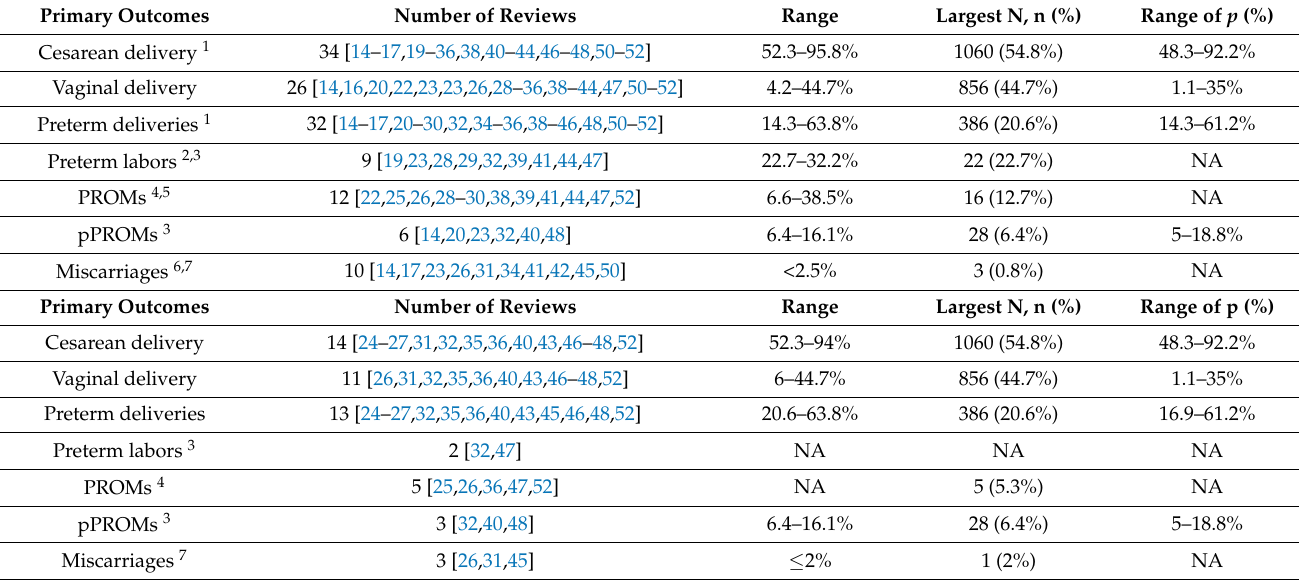
Table 1. Primary outcomes. Ranges of rates and data extracted from the review with the largest sample are reported. Columns demonstrate analyzed outcomes, number of reviews that provided relevant data on the outcome, range of extractable raw rates, the extracted rate from the largest sample analyzed for the outcome and range of extracted pooled rates. Results are extracted from all eligible systematic reviews. Results are extracted only from moderate and high-quality reviews. Bold denotes differences between the two